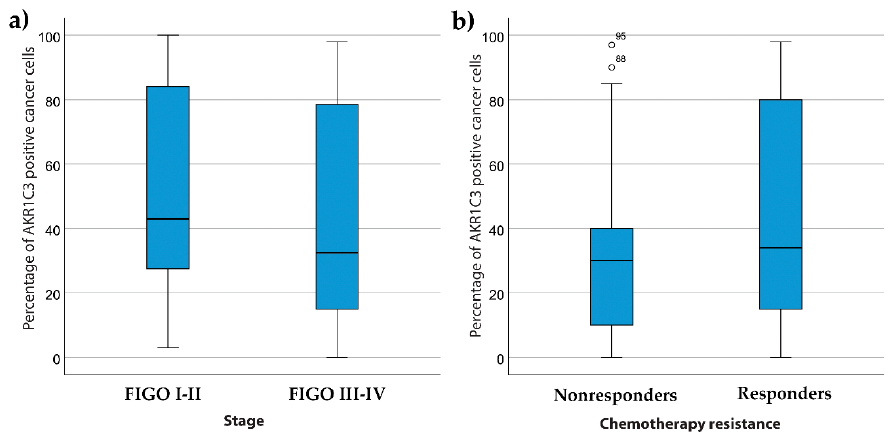
Figure 8. AKR1C3 distributions between patients with high-grade serous ovarian cancer and FIGO stages ( a ) and different response to chemotherapy ( b ). Median values, box from 25th to 75th percentiles, with whiskers that correspond to 25th percentile minus 1.5 times IQR (interquartile range) and to the 75th percentile plus 1.5 IQR are shown.